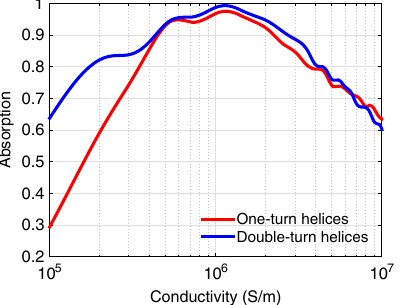
FIG. 4. Absorption coefficient versus conductivity of the inclusion material at the operating frequency of 3 GHz.